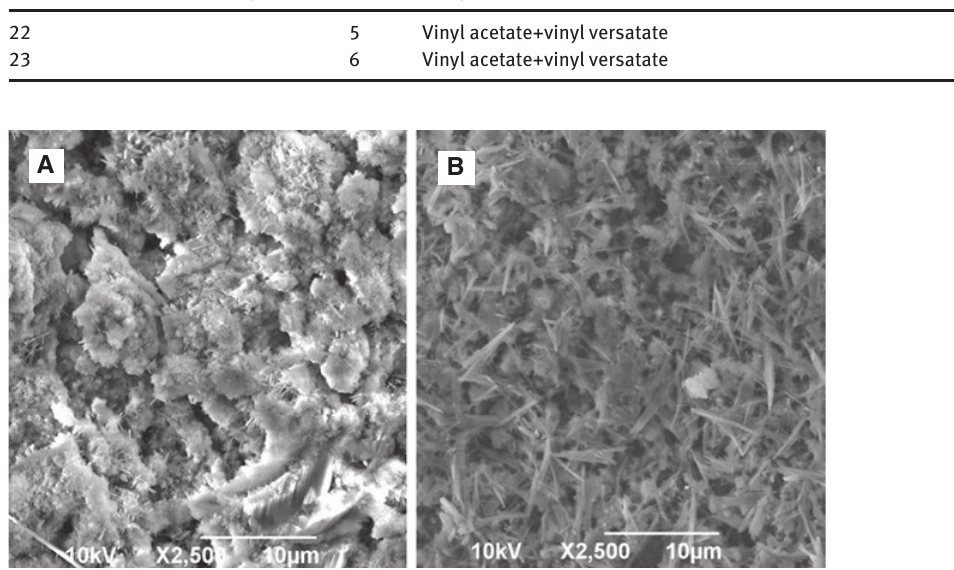
O +2.5% RDP-22 wet mixing (B). 2 3